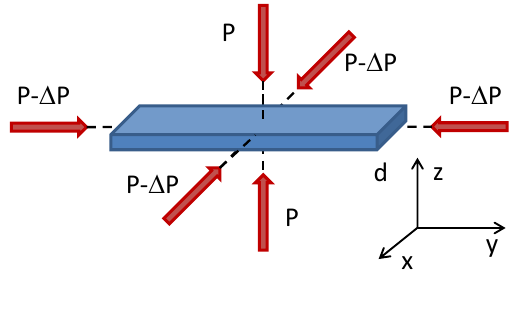
Figure 5: Schematic representation of the stress situa- tion inside the DAC for a slab of thickness d . The stress tensor can depart from hydrostatic (∆ P (cid:54) = 0), if d →